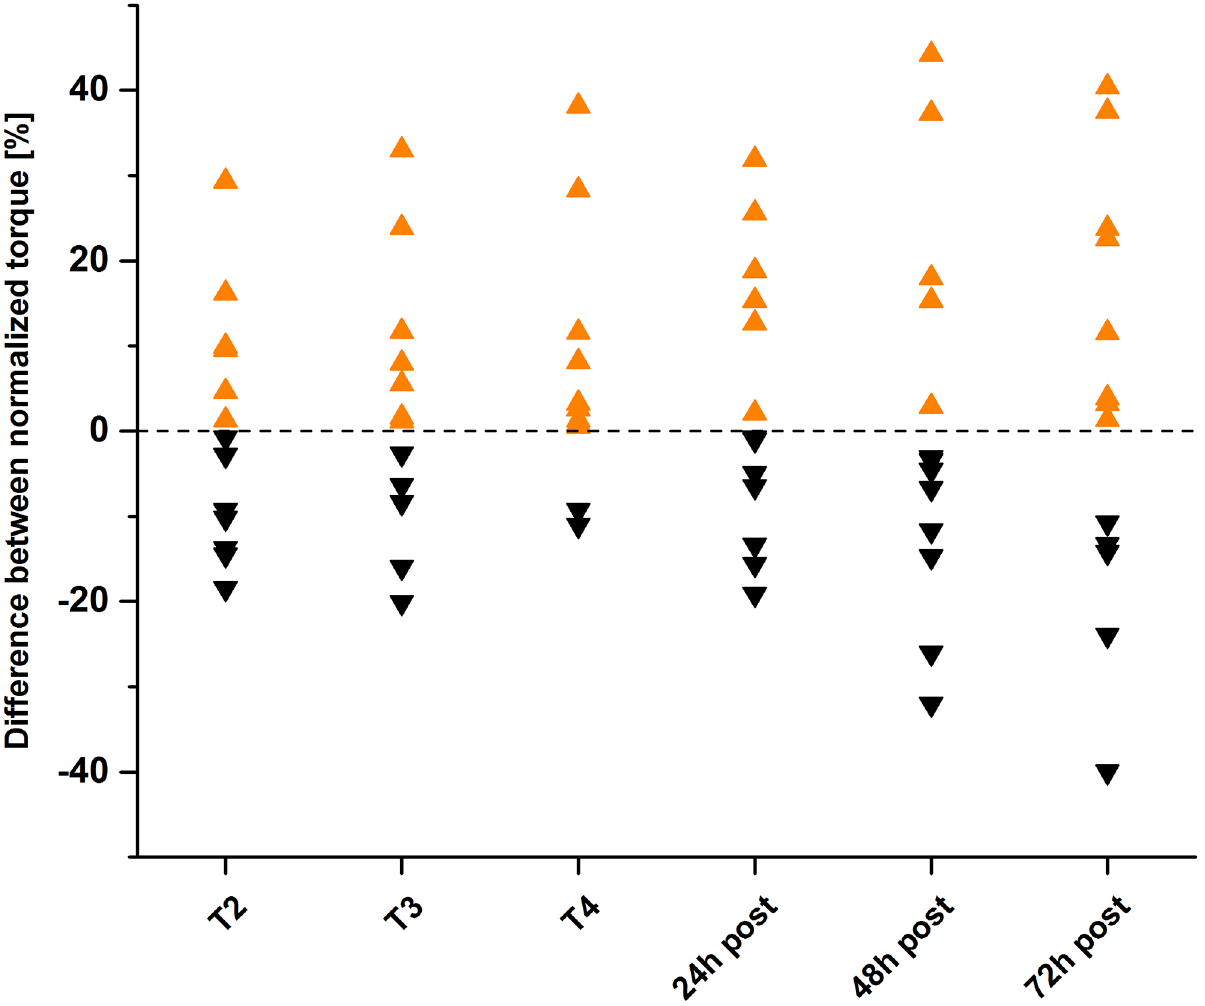
Fig 3. Individual normalized torque differences between baseline MVC measurement and post measurements. Differencebetween normalizedtorque for every participantat every testing session. Torque difference was calculatedas the difference from normalizedMVC Venex minus placebo.Orange symbols show a difference in favour for Venex and black symbols mean a difference in favour for Placebo. If a participanthad a relatively higherMVC duringthe Venex treatment comparedto the placebotreatment at a given testing session the value is an